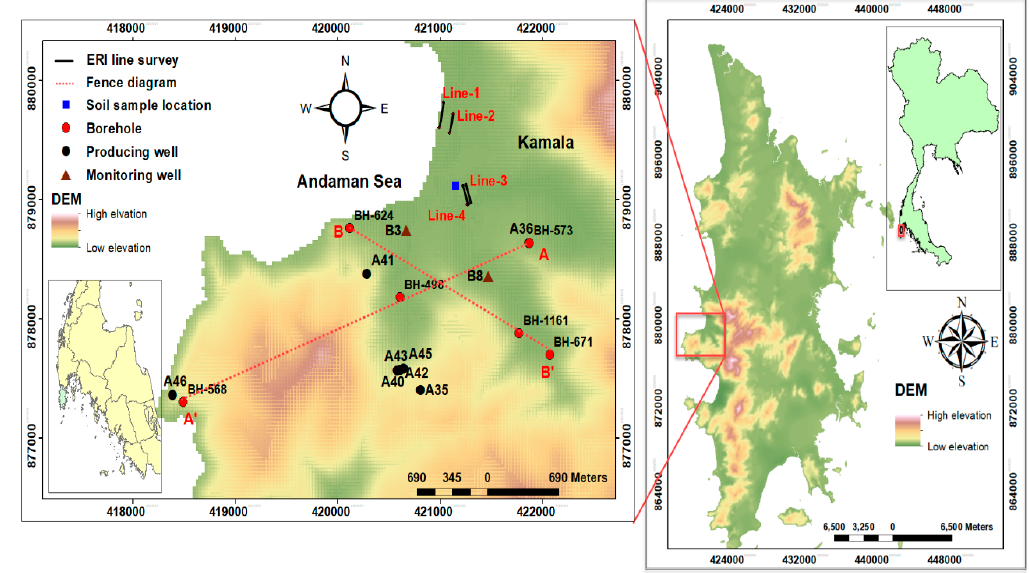
Figure2. Studyareashowingelectricalresistivityimaging(ERI)linesurveys, soilsampling, cross-section Figure 2. Study area showing electrical resistivity imaging (ERI) line surveys, soil sampling, cross- lines, and groundwater wells. section lines, and groundwater wells.